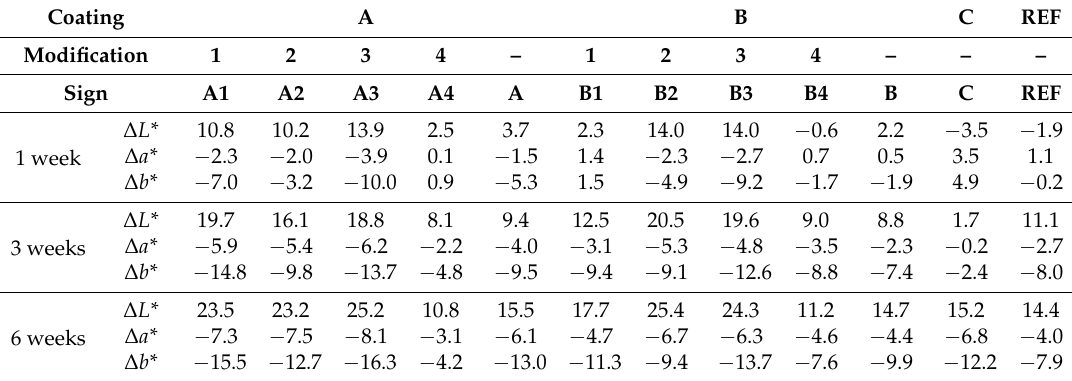
Table 4. Relative changes in the colour parameters ∆ L* , ∆ a* , ∆ b* (CIELab 1986 [58]) of the tested samples after 1, 3, and 6 weeks of artificial weathering. (Mean values from 12 measurements) Coating A REF